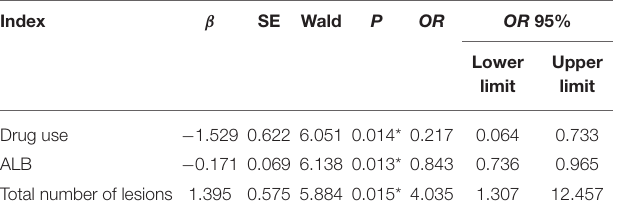
TABLE 2 | Multiple logistic regression analysis of factors influencing the degree of disability in MS patients.